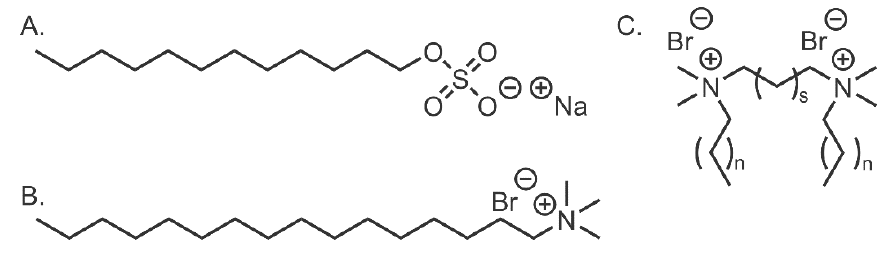
Figure 5. Examples of ( A ), anionic, ( B ), cationic and ( C ), Gemini